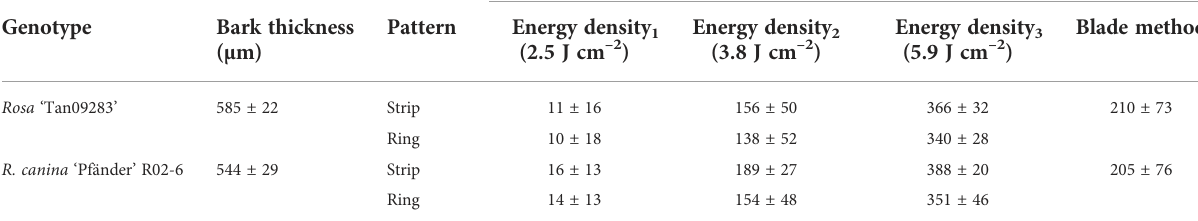
TABLE 2 Penetration depth of laser wounding treatments (three different energy densities and manual wounding by blades) on rose cuttings depending the genotype (n =